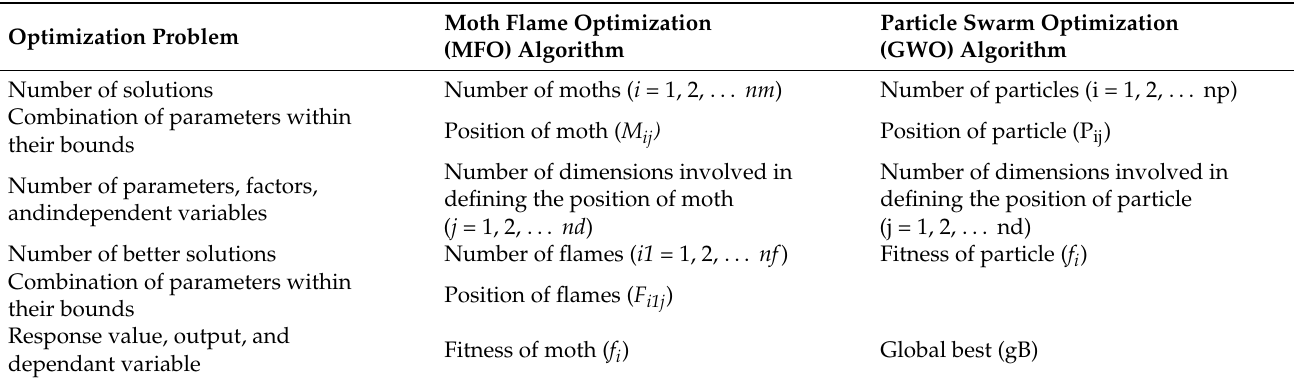
Table 11. Terms in MFO and PSO optimization